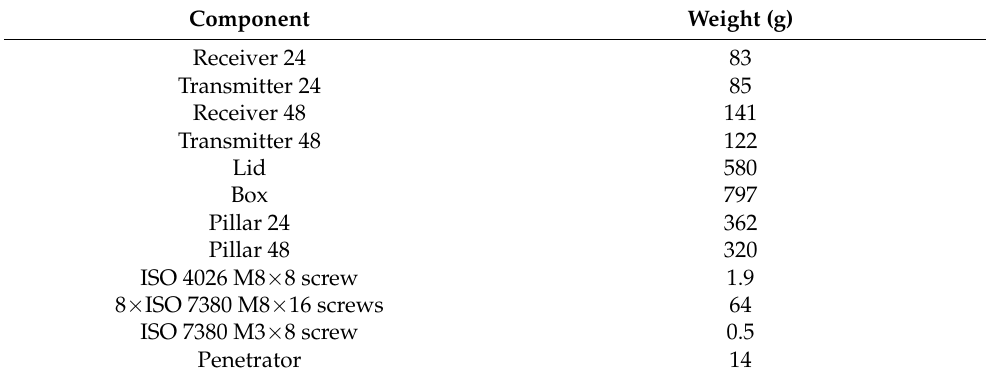
Table 8. WCH components weight.